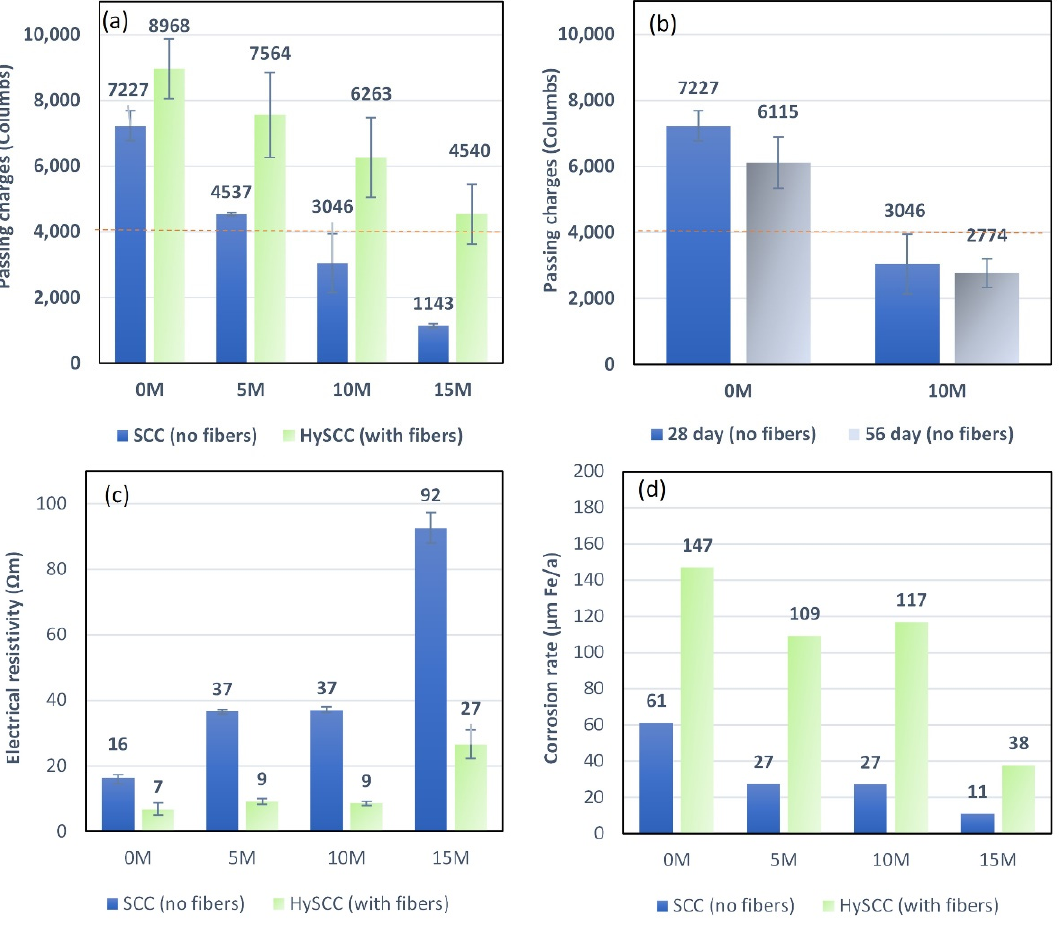
Figure 6. Influence of M content on ( a ) total charge passing in RCPT for the SCC and HySCC samples, ( b ) total charge passing in RCPT for the SCC samples at 28 and 56 days, ( c ) electrical resistivity of the SCC and HySCC samples, and ( d ) corrosion rate in µm Fe per year for the SCC and HySCC samples.